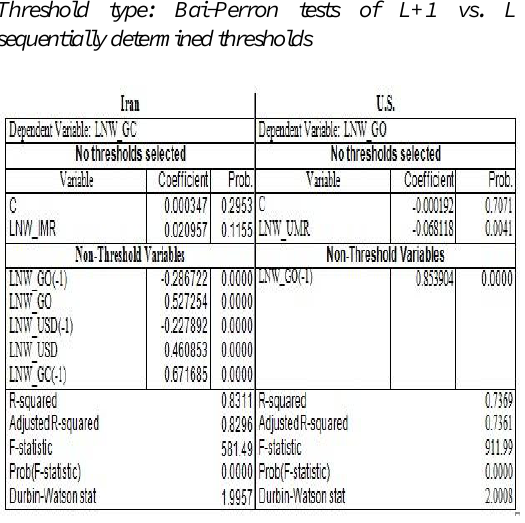
Table 7: Investigating the Existence of Different Regimes in the Relationship between the Weekly Return of the Stock Markets of the U.S. and Iran and Gold Method: Threshold